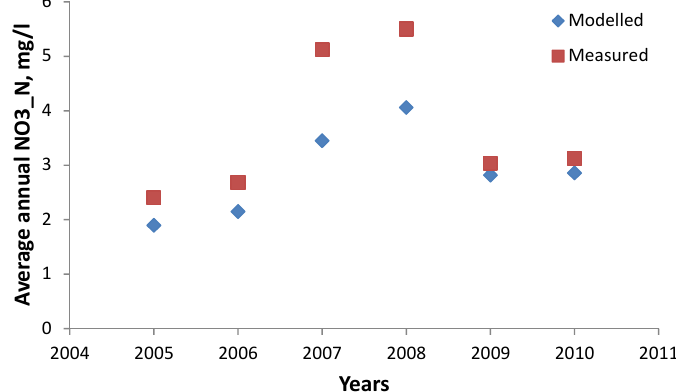
Figure 3. Measured and modelled nitrate nitrogen and water